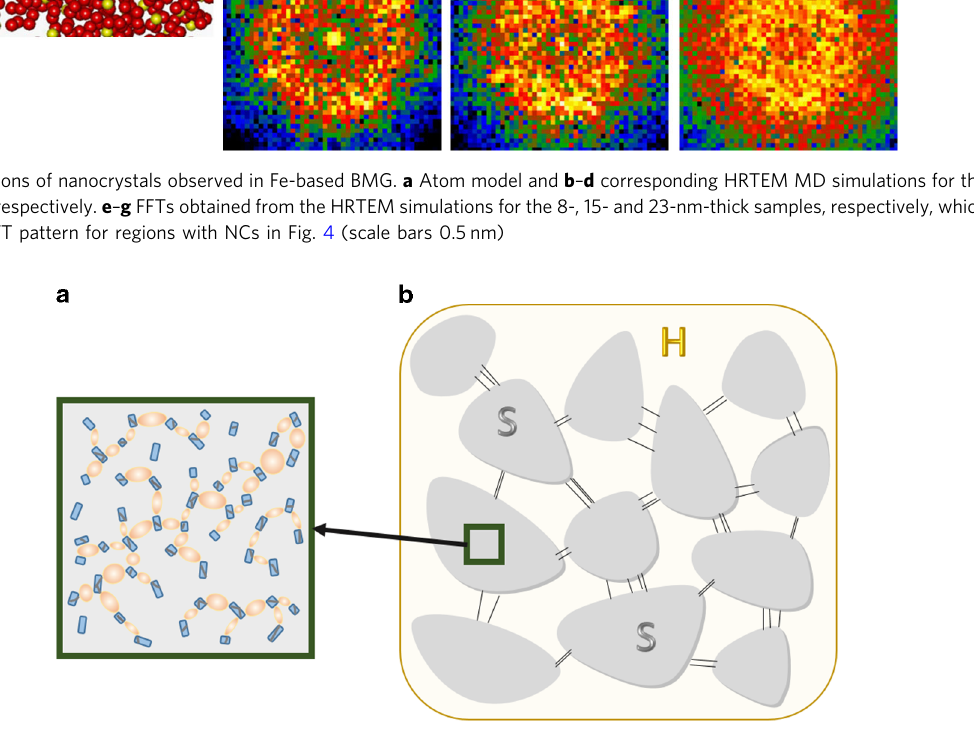
Fig. 7 Schematics describing multiscale deformation behavior in Fe 50 Ni 30 P 13 C 7 BMG. a Nanocrystals (blue particles) have lower shear modulus compared to the BMG, thereby deforming fi rst (small gray lines within NCs). Deformation proceeds by the formation of homogenously dispersed STZs between NCs. b On the micro-scale, SBs do not develop into cracks because the distance between the soft regions is smaller than the critical crack length of the BMG (as in the case for ref. 9 containing plastically soft and hard